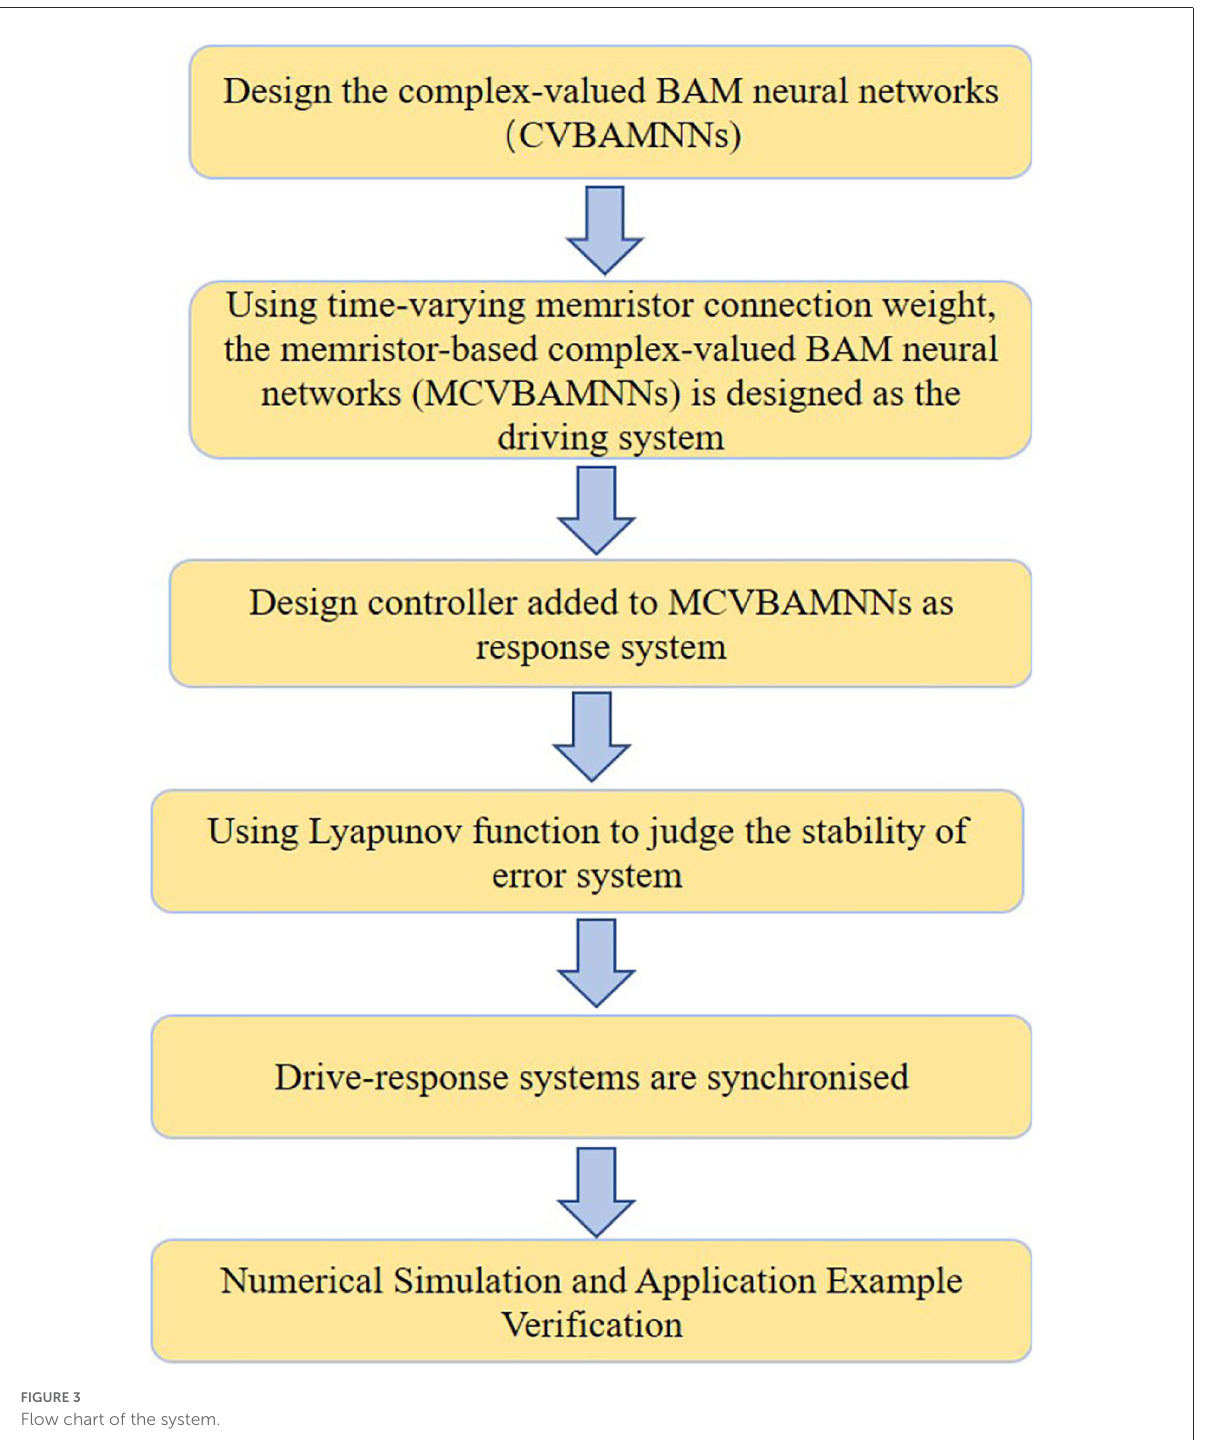
FIGURE3 Flow chart of the